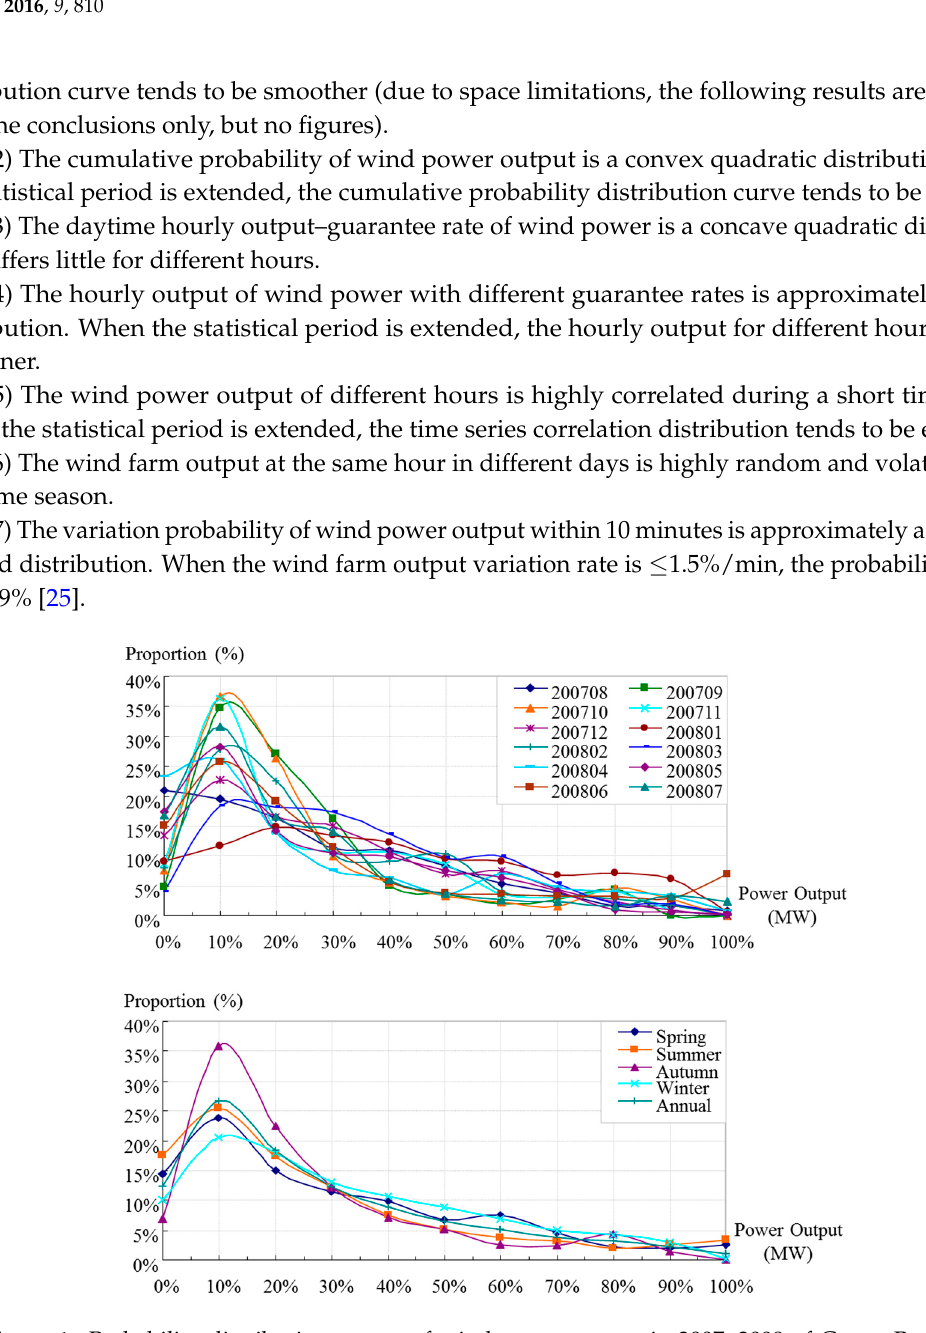
Figure 1. Probability distribution curves of wind power output in 2007~2008 of Gansu Province wind farms.